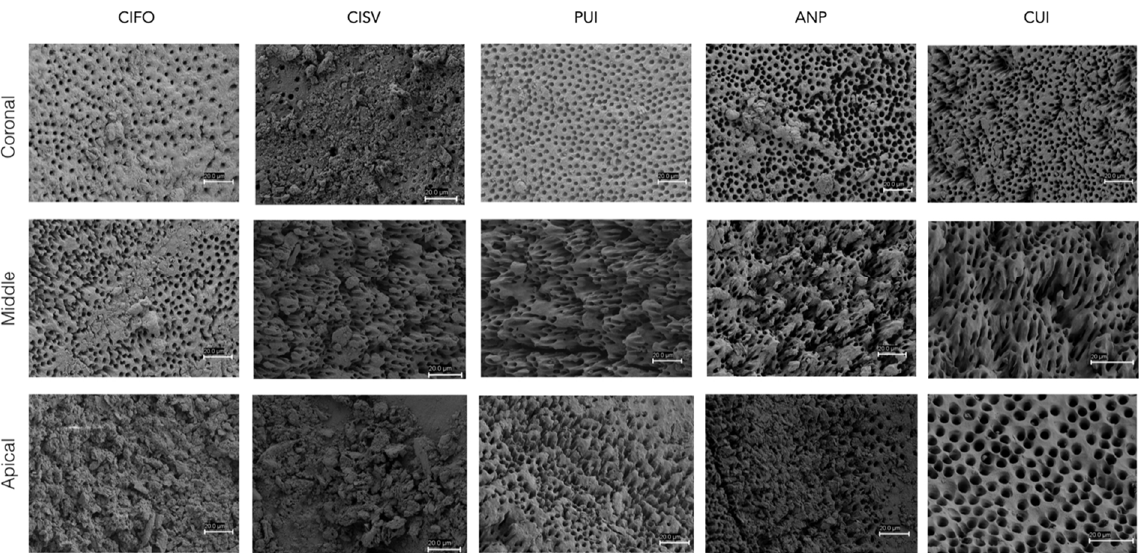
Figure 1. Representative SEM images of the coronal, middle and apical root thirds of each irrigation protocol (×1000 magnification, secondary electron mode, 5 KV accelerated voltage).